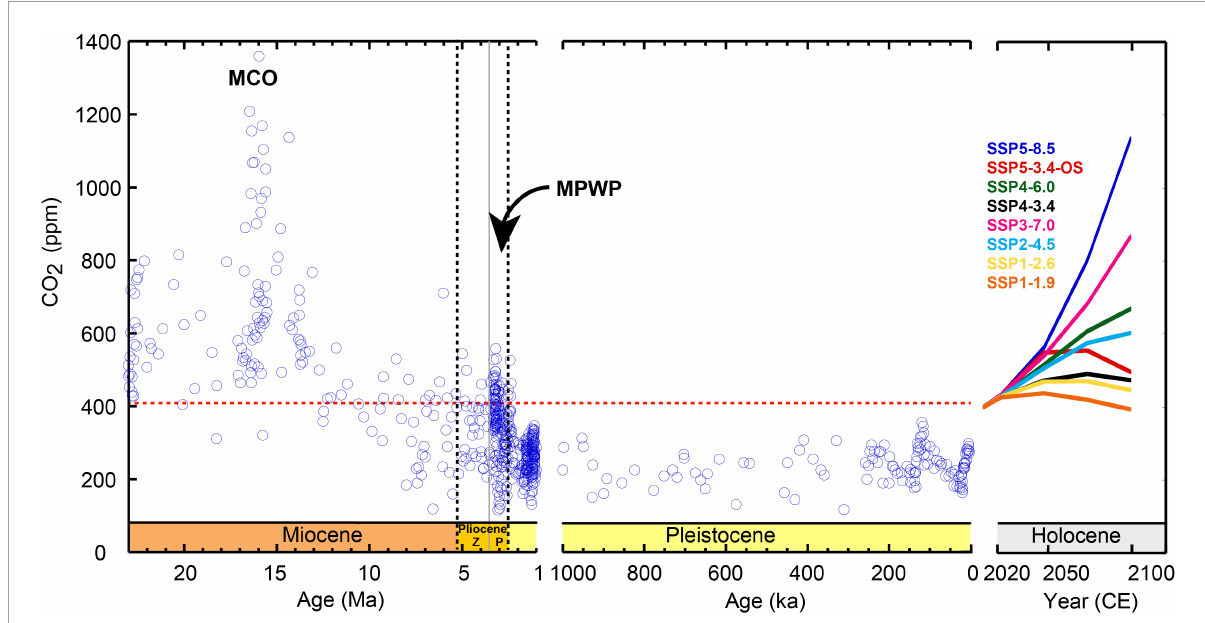
FIGURE1 Paleoclimate as context for future climate change scenarios. CO 2 scenarios associated with different socio-economic pathways (Meinshausen et al., 2020) are shown in color as model projections for future. Mid-Piacenzian Warm Period (MPWP) and Miocene Climatic Optimum (MCO). Horizontal red dashed line indicates current CO 2 of ∼ 410 ppm. Note breaks in age axis. Zanclean and Piacenzian Ages of the Pliocene Epoch denoted by Z and P respectively. CO 2 data are from Zhang et al. (2013), Pagani et al. (2010), Foster (2008), Hönisch et al. (2009), Badger et al. (2019), Chalk et al. (2017), Sosdian et al. (2018), Dyez et al. (2018), Martinez-Boti et al. (2015), de la Vega et al. (2020), and Greenop et al. (2014), and suggest the Earth has not experienced present–day levels of CO 2 in 3 million years. Modified after Rae et al.